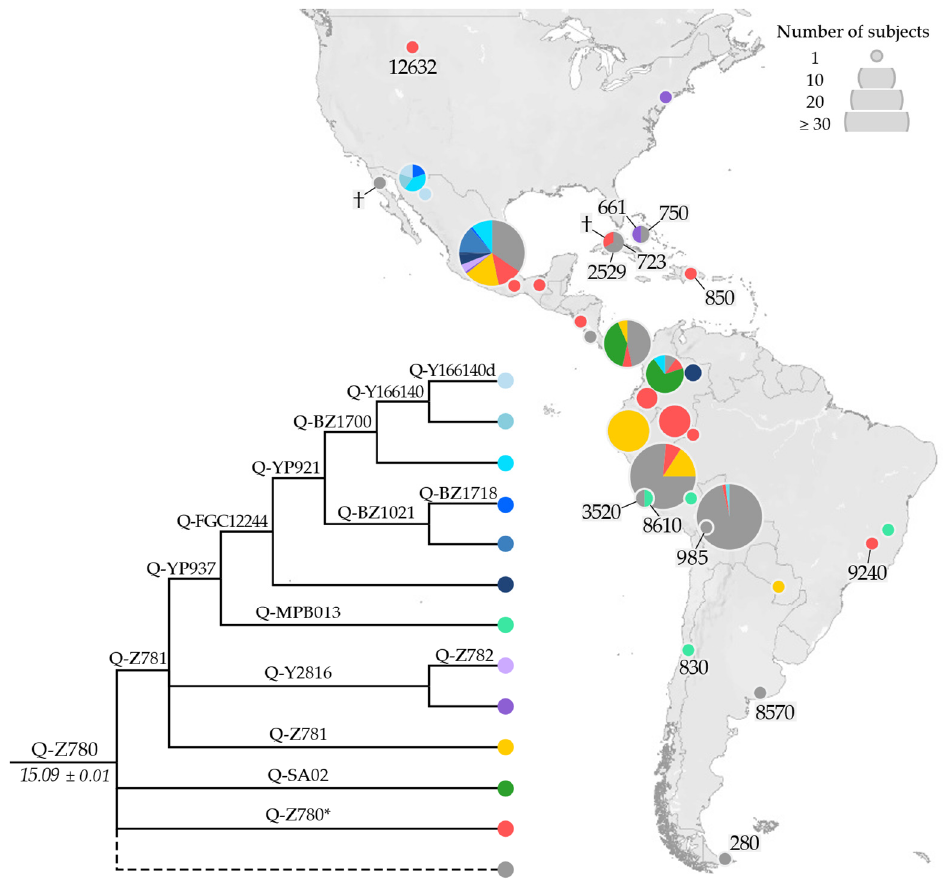
Figure 4. Geographical distribution of Q-Z780 (ISOGG nomenclature: Q1b1a2—http://www.isogg.org/tree/, accessed on 19 January 2022) and its main sub-lineages. Ancient individuals are indicated with their median calibrated age (cal BP, see Table S1 for details), or with a cross when the age was not available. The dashed line comprises Q-Z780 samples less well defined (missing positions of informative downstream markers). In the phylogeny, the estimated age of the node ( ± StDev) is reported in